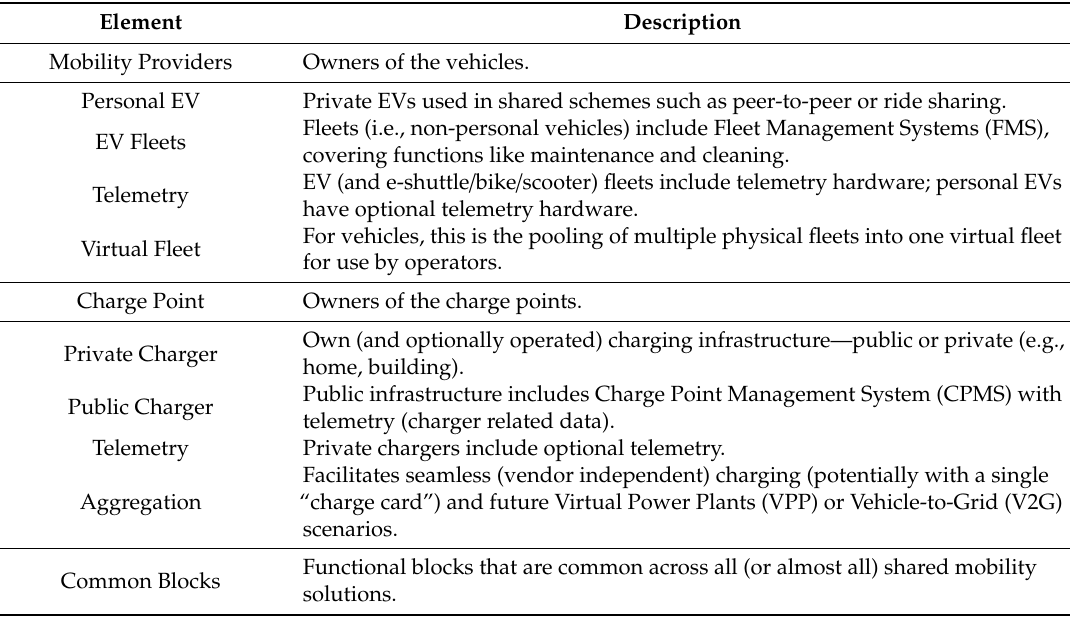
Table 3. Elements of the Shared e-Mobility block in the eMaaS system architecture.